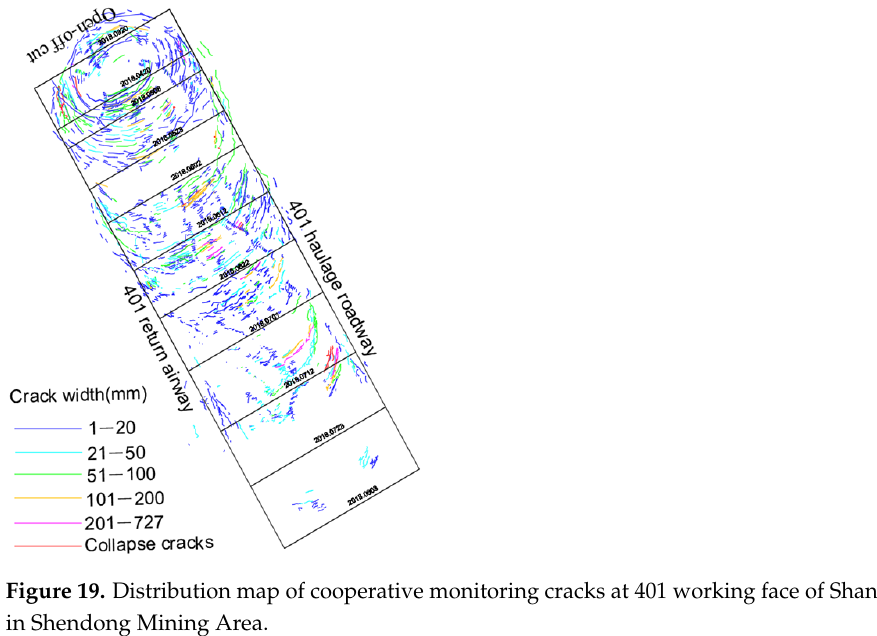
in Shendong Mining Mine in Shendong Mining A rea .